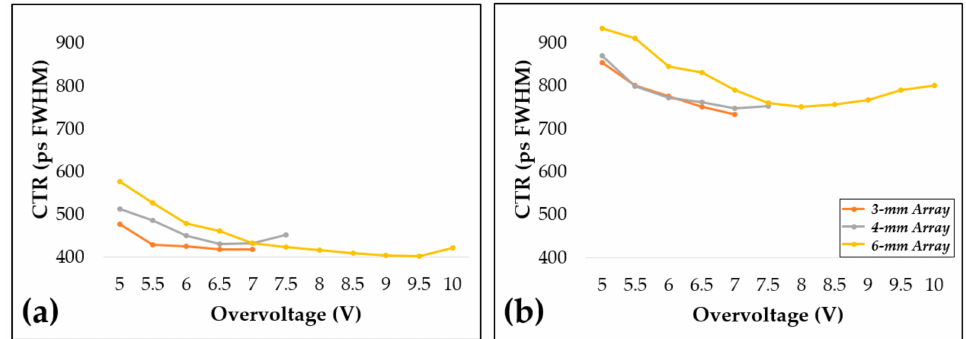
Figure 9. Average coincidence timing resolution (CTR) as a function of overvoltages: ( a ) With and ( b ) without application of the analog high-pass